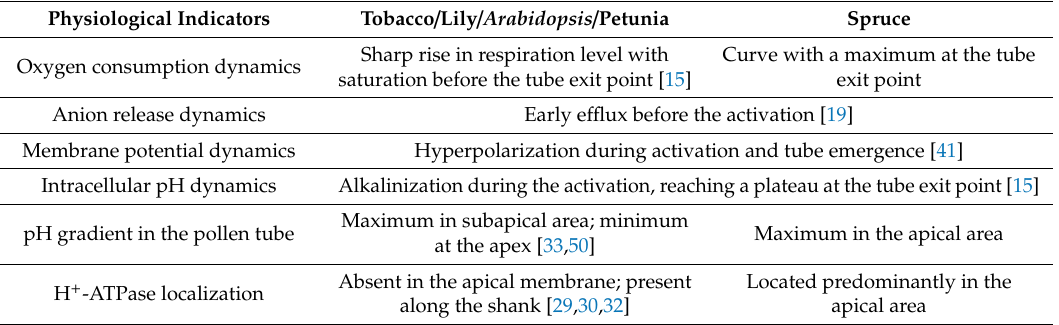
Table 1. Spatial and dynamical changes in physiological parameters in angiosperms and